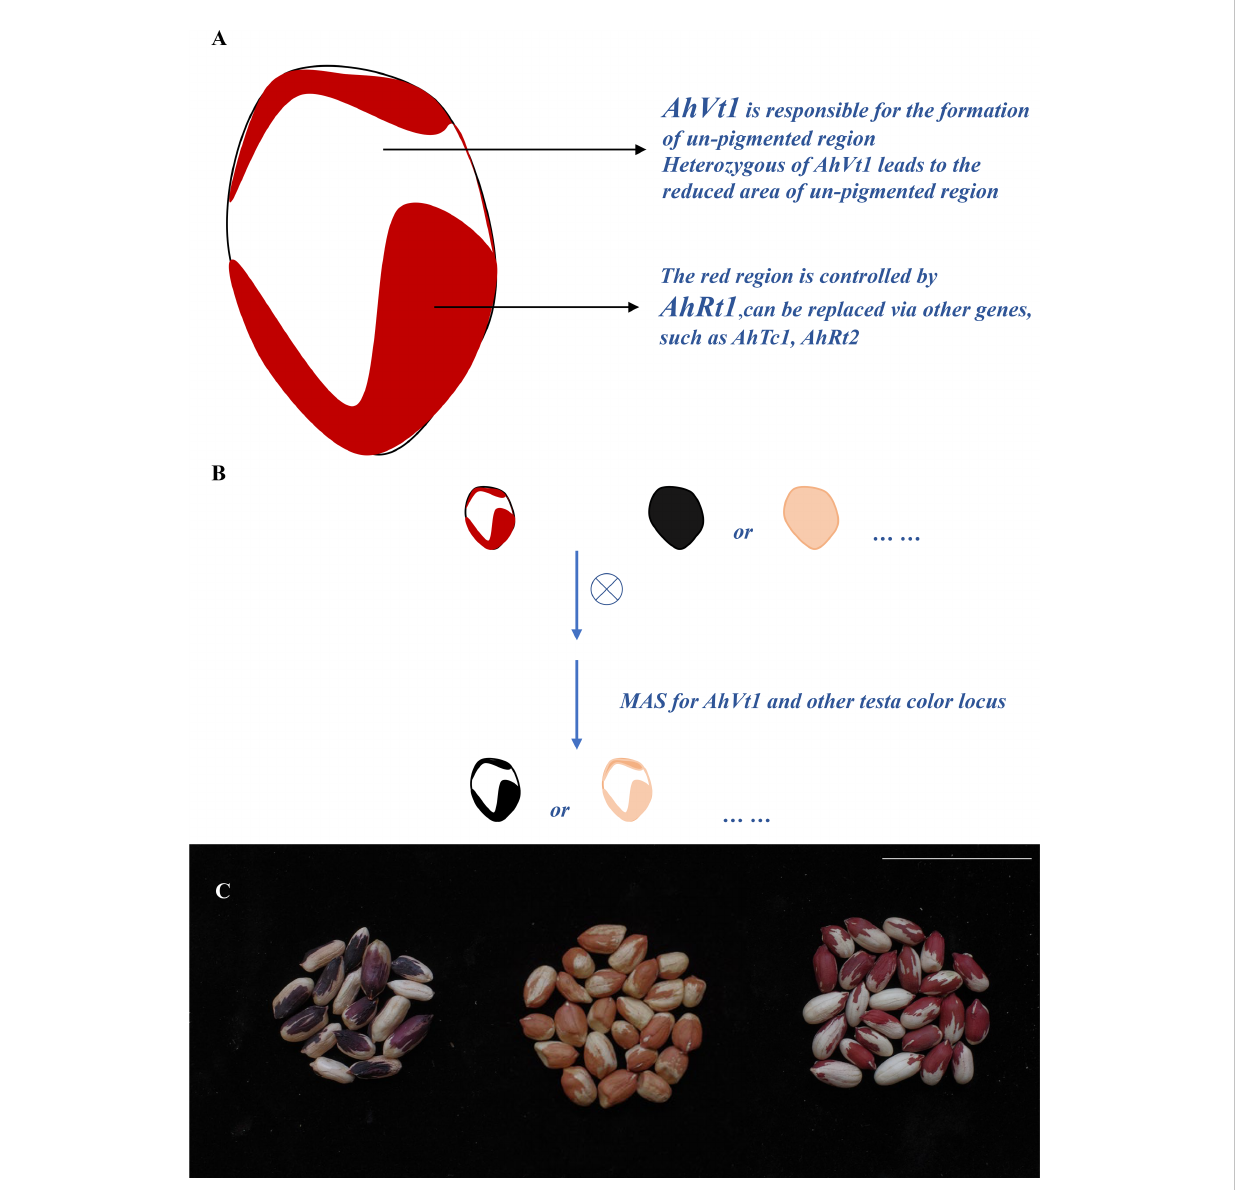
FIGURE 6 Development new variegation testa pattern peanut lines by marker-assist selection (MAS) approach. (A) . Work model for AhVt1 in formatting the variegation testa. (B) . Development of the new variegation testa pattern peanut lines by MAS. (C) . The seed of new developed black on white variegated and pink on white variegated testa peanut lines. Scale bar = 5